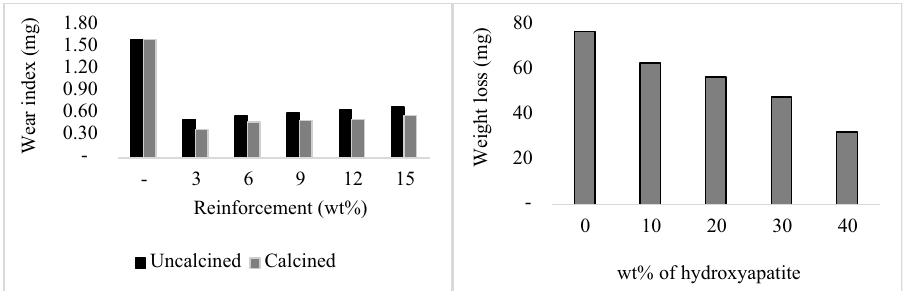
Figure 5: Wear indices of uncalcined and calcined ESs [ 57 ] and weight losses of composites [ 106 ] . Figures are produced based on the data in [ 57 ] and [ 106 ]